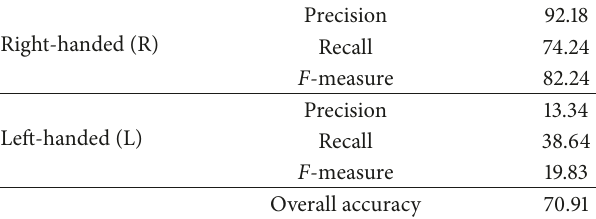
Table 7: Performance results for handedness classification on KHATT database.